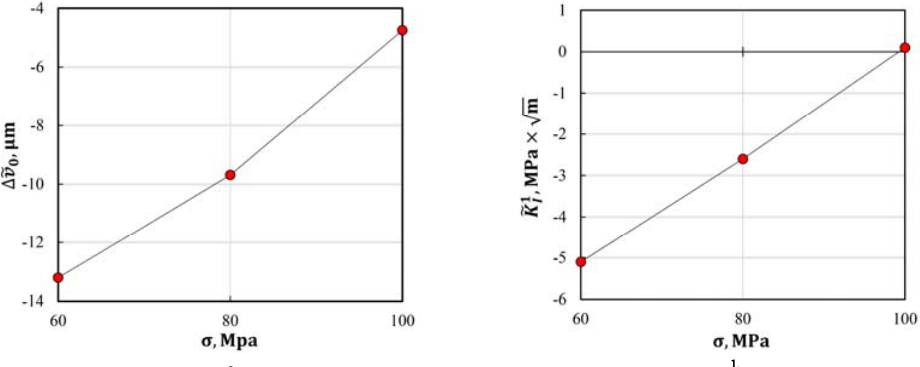
v (a) and SIF (b) as a function of remote stress level σ 0